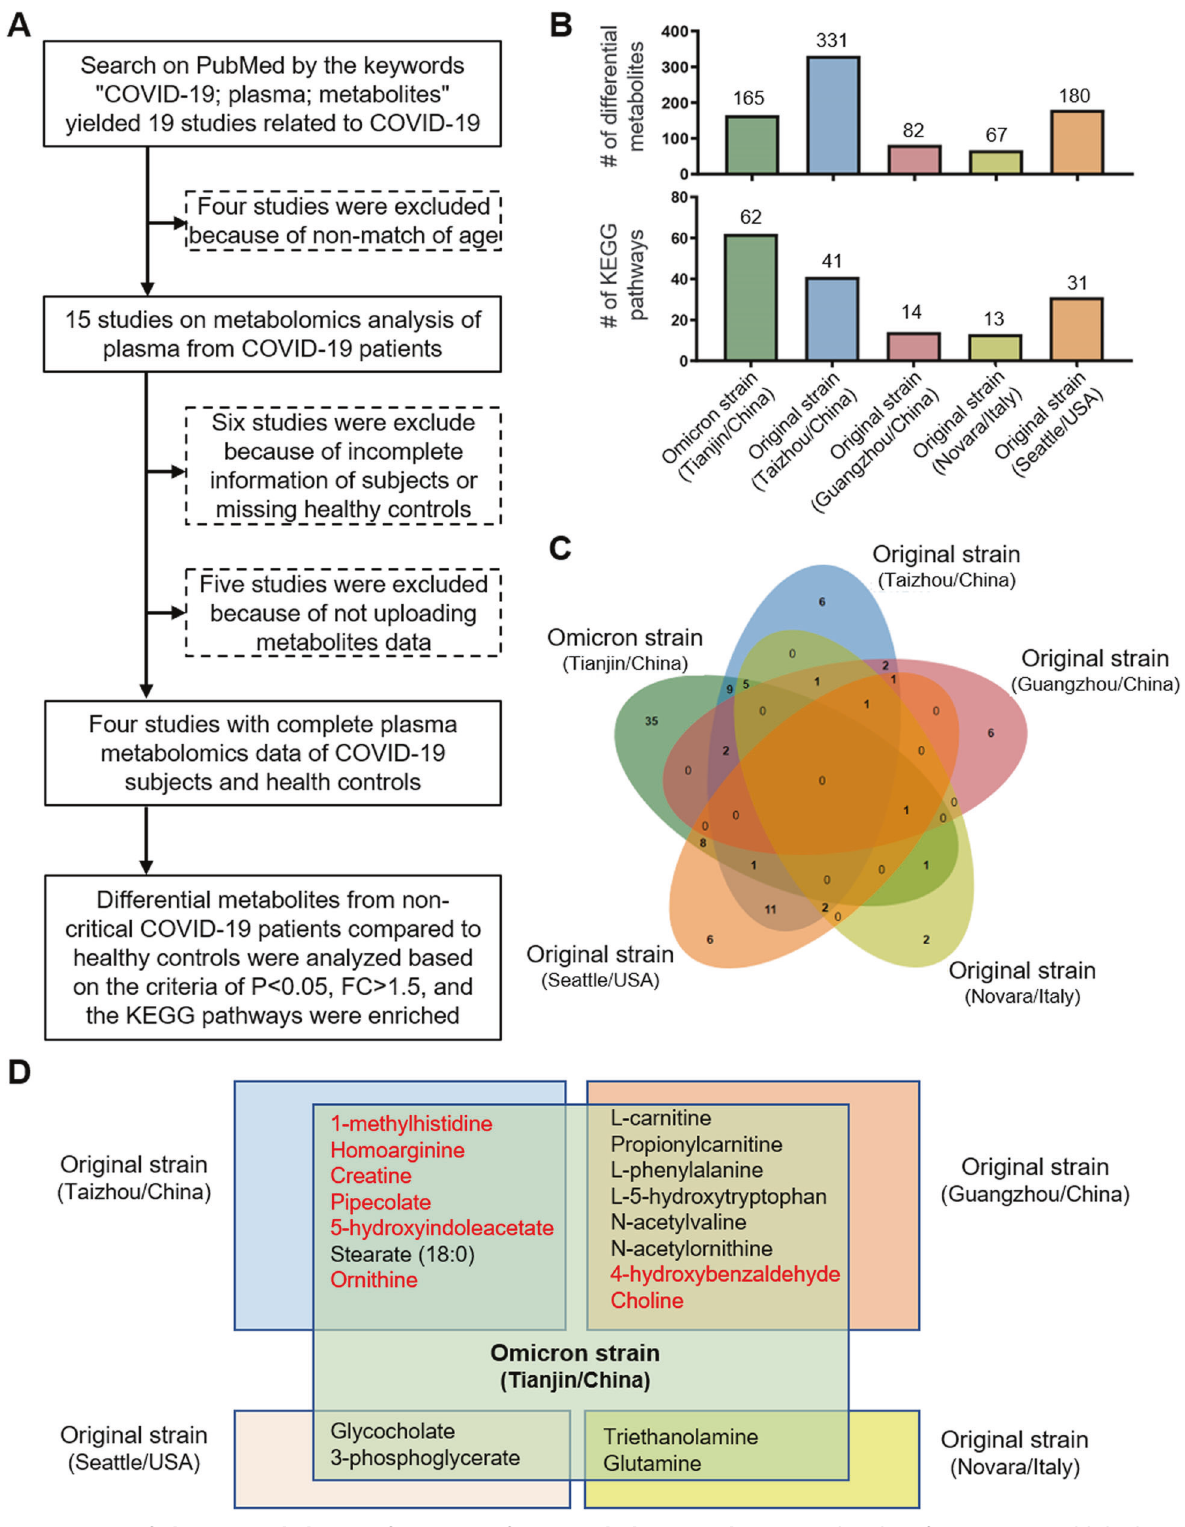
Fig. 5 Comparison of plasma metabolomics of Omicron infection with the original strain. A Flowchart for screening published articles of plasma metabolomic analysis in patients with COVID-19. B The number of differential metabolites and KEGG enrichment pathway in patients with COVID-19 infected with Omicron and the original strains. C The Venn diagram compares enrichment pathways between the Omicron and the original strains. D Shared differential metabolites in patients infected with the Omicron and the original strains, respectively. The red metabolites present the opposite change from Omicron patients to the original strain.